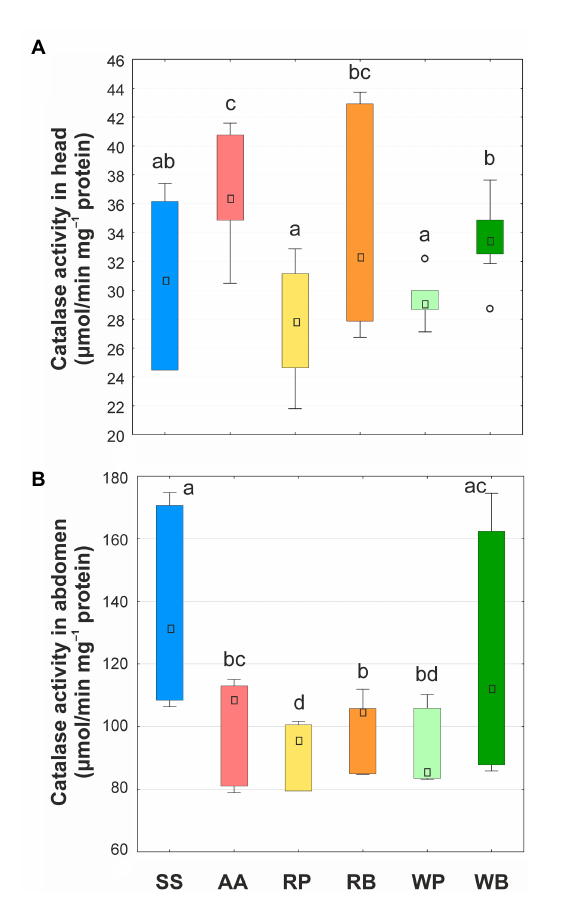
FIGURE 5 Catalase activity ( μ mol/min mg − 1 protein) in heads (A) and abdomens (B) of worker bees consuming different diets. SS, sucrose solution (control group); AA, sucrose solution + amino acids; RP, sucrose solution + rapeseed pollen; RB, sucrose solution + rapeseed beebread; WP, sucrose solution + willow pollen; WB, sucrose solution + willow beebread. Boxes show first and third interquartile ranges with the dot denoting median. Whiskers encompass 90% of individuals, beyond which outliers are represented by circles. Different letters indicate significant differences between the values ( p <